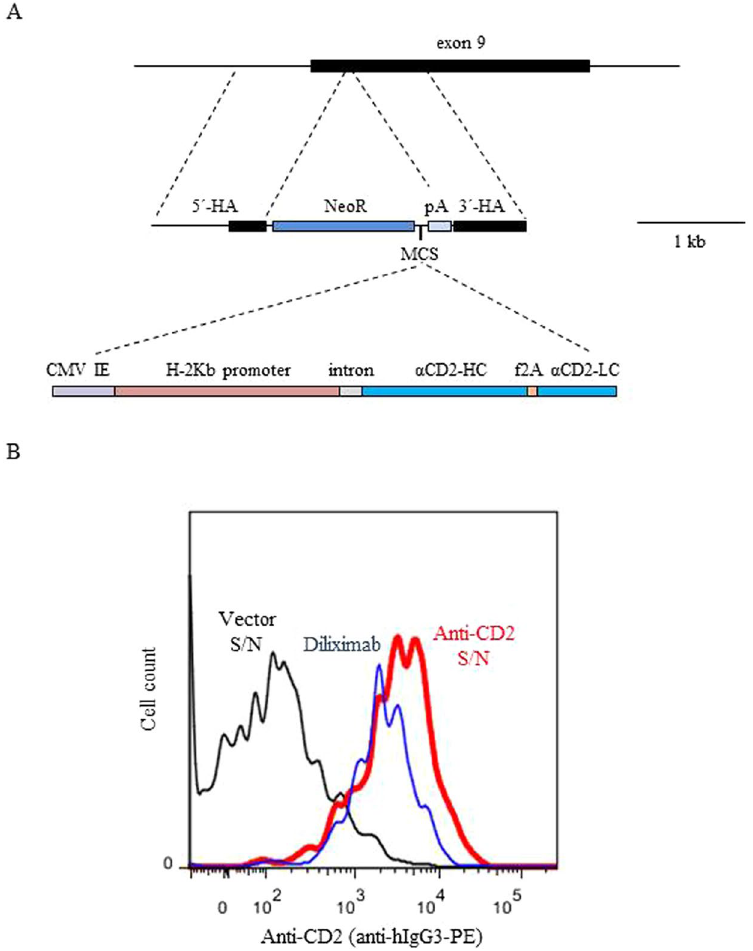
Figure 2. Validation of the anti-CD2 mAb GGTA1 targeting construct. ( A ) Top, GGTA1 genomic structure. Middle, knock-in backbone showing 5 ′ and 3 ′ homology arms (5 ′ -HA and 3 ′ -HA), neomycin resistance cassette (NeoR), multiple cloning site (MCS), and polyadenylation signal (pA). Into this was cloned (bottom) the CMV immediate early enhancer (CMV IE), mouse H-2K b promoter, intron, and coding regions for the heavy and light chains of anti-CD2 mAb diliximab ( α CD2-HC and α CD2-LC) linked by a furin cleavage site-F2A ribosome skip signal (f2A). The isotype of diliximab is human IgG3. ( B ) Detection of anti-CD2 mAb diliximab secreted by stably transfected COS-7 cells. Human leukocytes were incubated with culture supernatant, and mAb binding to CD3 + T cells was detected with anti-human IgG3. Red line, supernatant (S/N) from COS-7 cells transfected with the anti-CD2 knock-in construct; blue line, positive control (62.5 ng/ml purified diliximab); black line, supernatant from vector-transfected